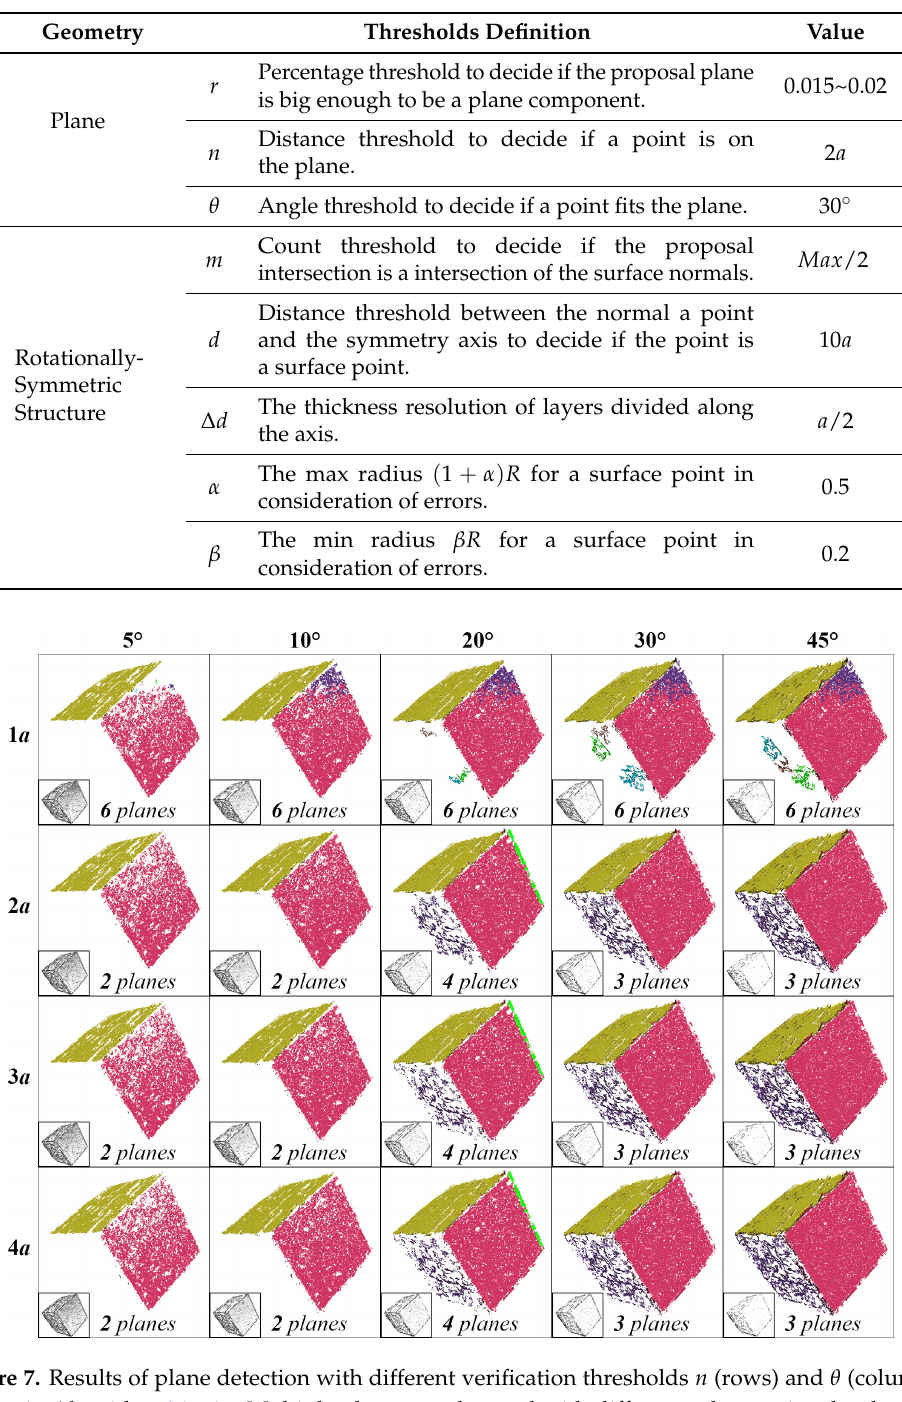
Table 1. Definition of thresholds used in point cloud refinement.